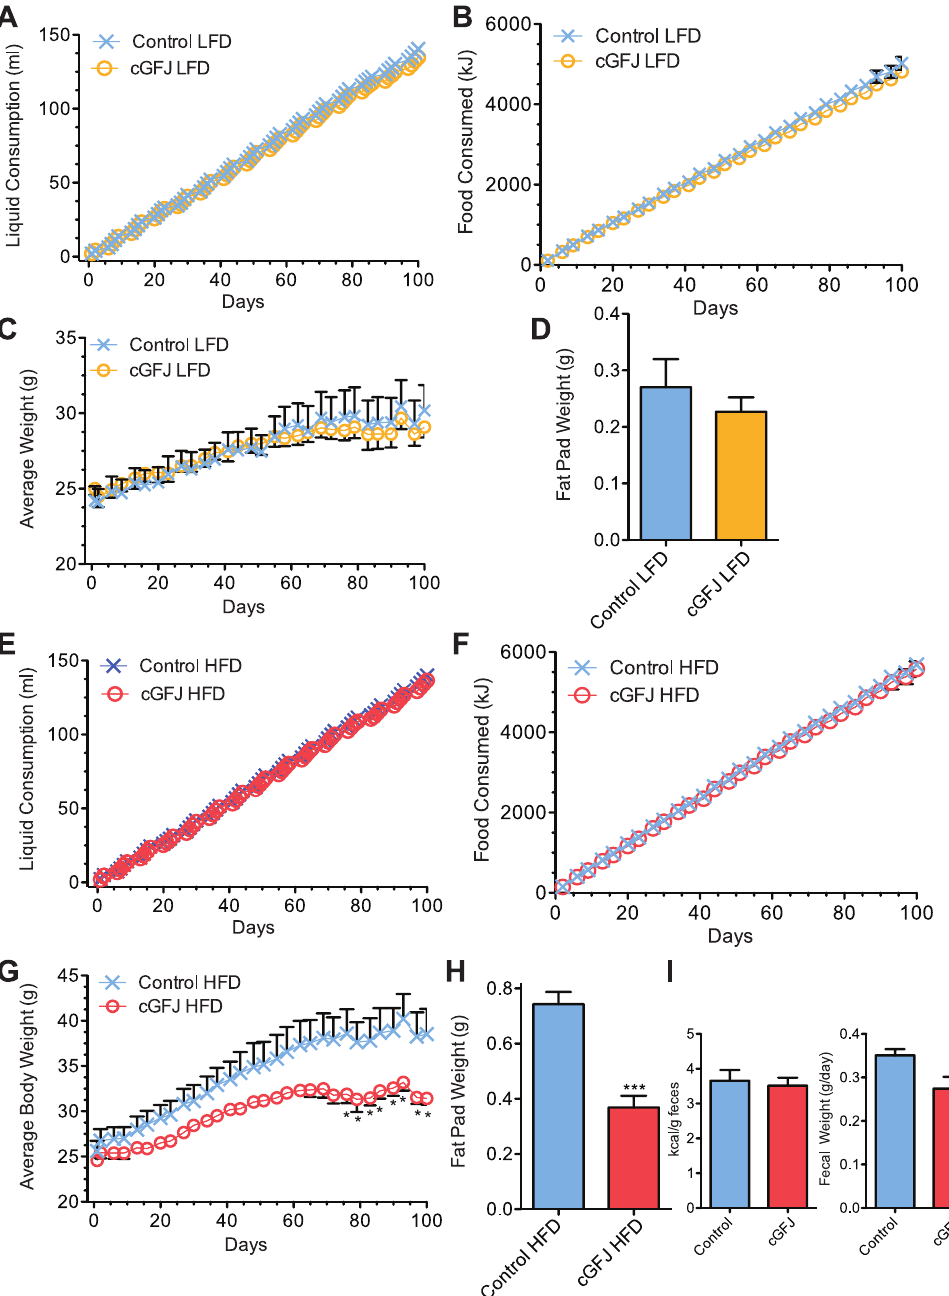
Figure 2. Effects of cGFJ on liquid and food intake, and weight. Mice were fed a LFD or HFD and 50% cGFJ for 100 days, starting from weaning (day 0) at 4 wk old. LFD: A) cumulative liquid consumption; B) cumulative food consumption; C) total body weights; D) intra-abdominal fat pad weight. HFD: E) cumulative liquid consumption; F) cumulative food consumption, *P , 0.05; G) total body weights, *** P =0.0001; H) intra- abdominal fat pad weight, P , 0.05 ; I) caloric content of feces of cGFJ and control water treated mice fed a HFD for 100 days, P . 0.7 and fecal weight of mice collected over 24 hr at the end of 106 days of treatment, P . 0.03 for GFJ. A two-tailed, unpaired t-test was used to determine statistical significance.